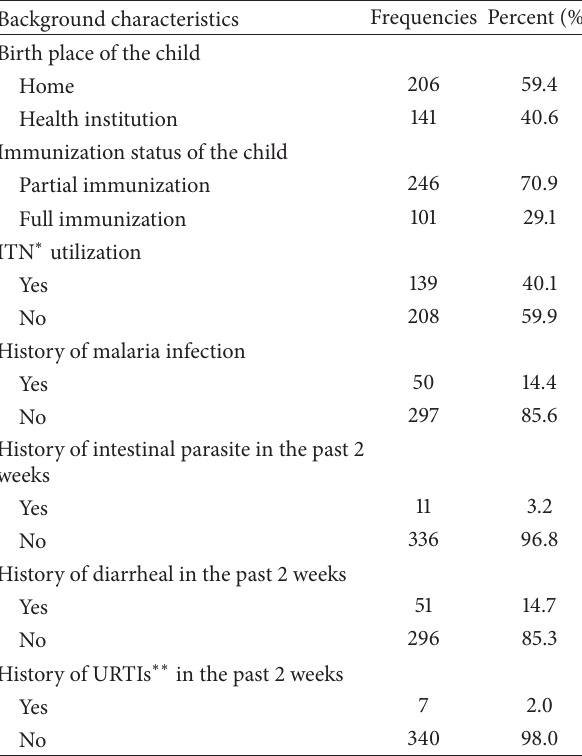
Table 2: Feeding practice and nutritional status of children aged 6–23 months attending growth monitoring clinic at Tsitsika Health Center, Northeast Ethiopia ( 𝑛 = 347 ).